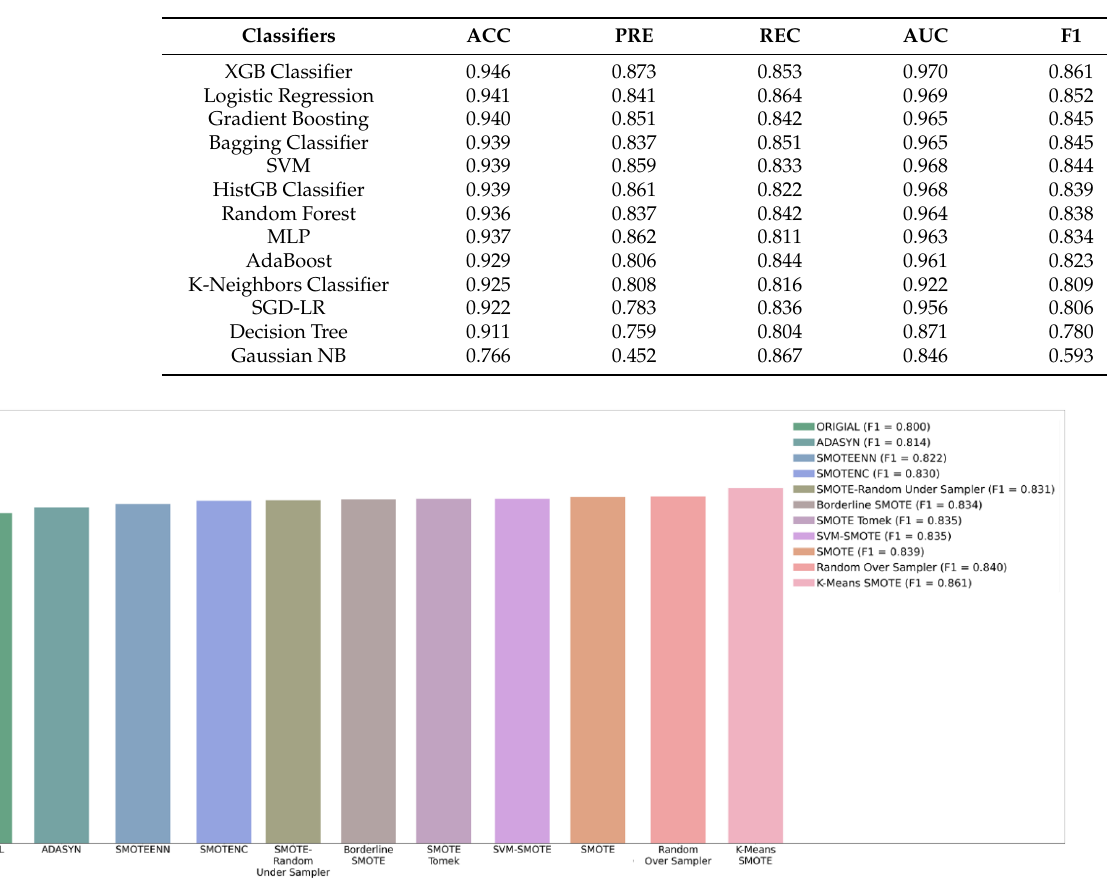
Figure 6. Comparison of F1-scores using 10 oversampling techniques. Table 5. Performance evaluation of 13 classifiers with K-means SMOTE.